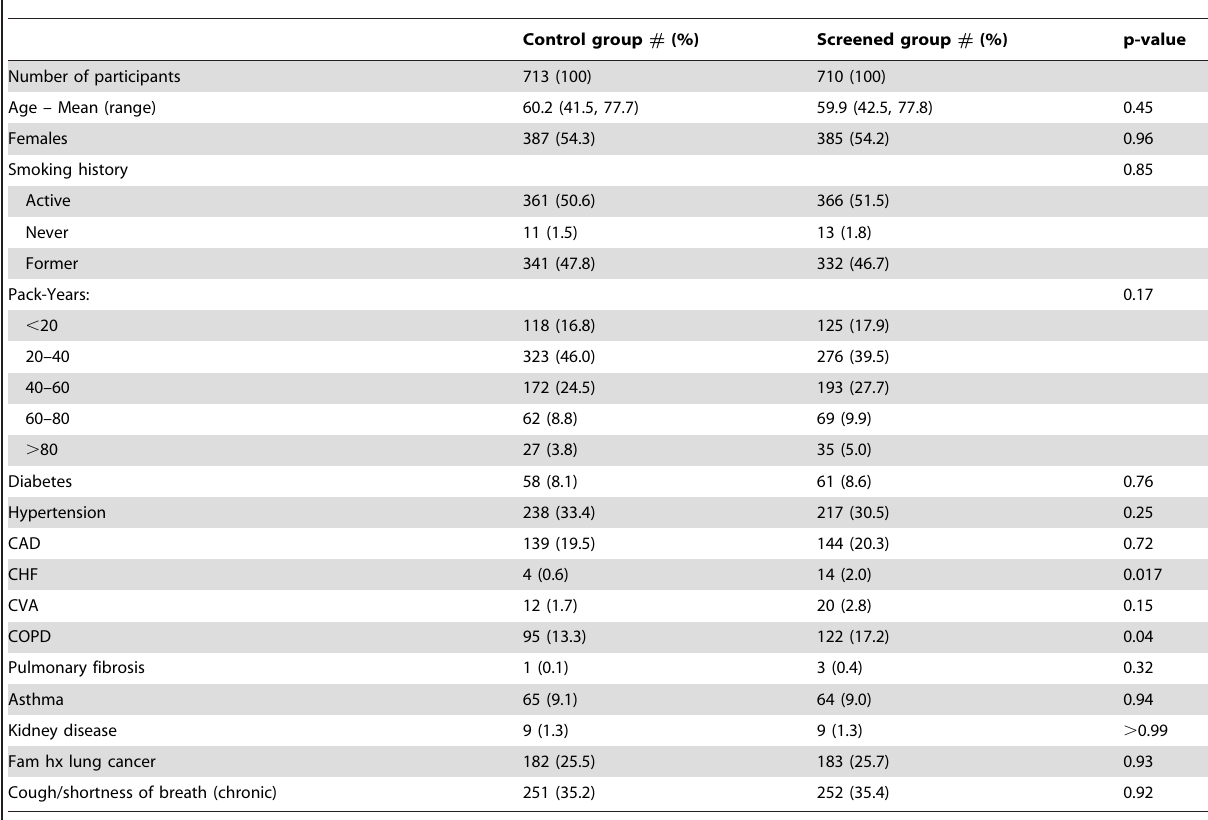
Table 2. Characteristics of study